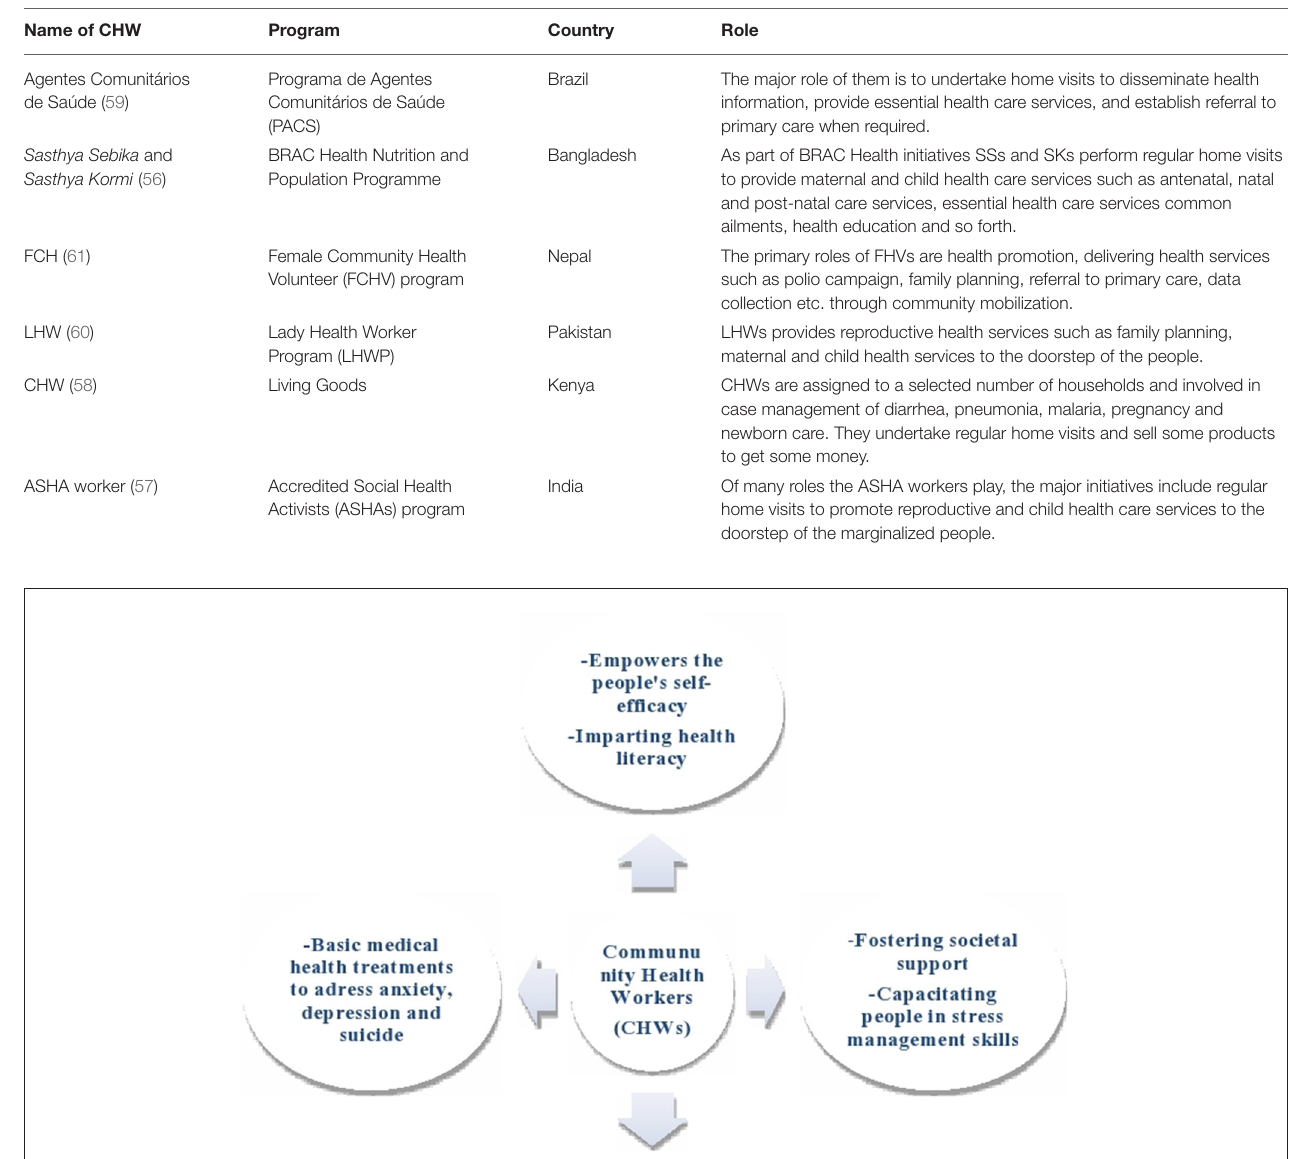
TABLE 1 | Overview of the major global CHW interventions.